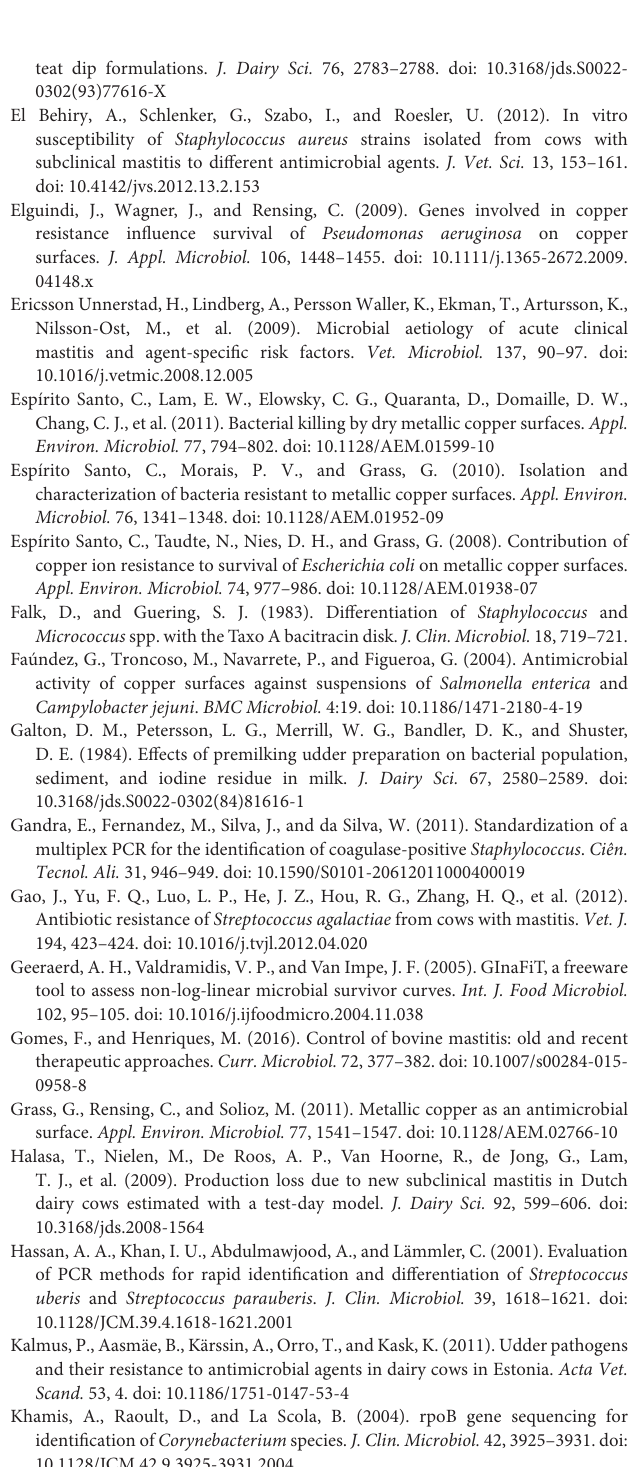
FIGURE S3 | Frequency of MIC-Cu values for microorganisms isolated from milk samples obtained from: (A) Central region (40 clinical and 42 subclinical mastitis) and (B) Southern region (86 clinical and 159 subclinical mastitis). Gray bars represent the frequency of microorganism isolated from subclinical mastitis and black bars are from clinical mastitis. Each determination was performed in